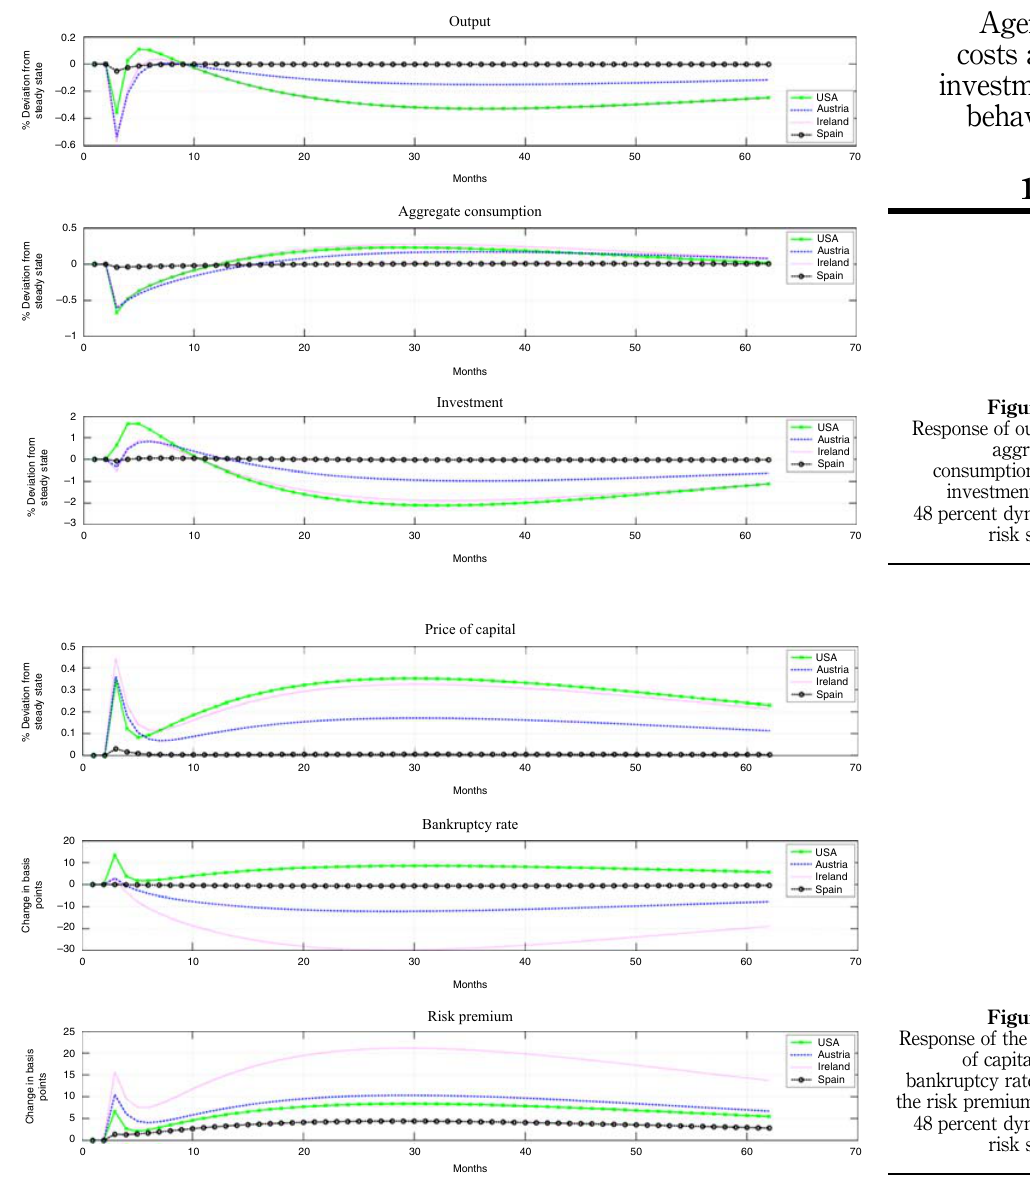
Figure 8. Response of output, aggregate consumption